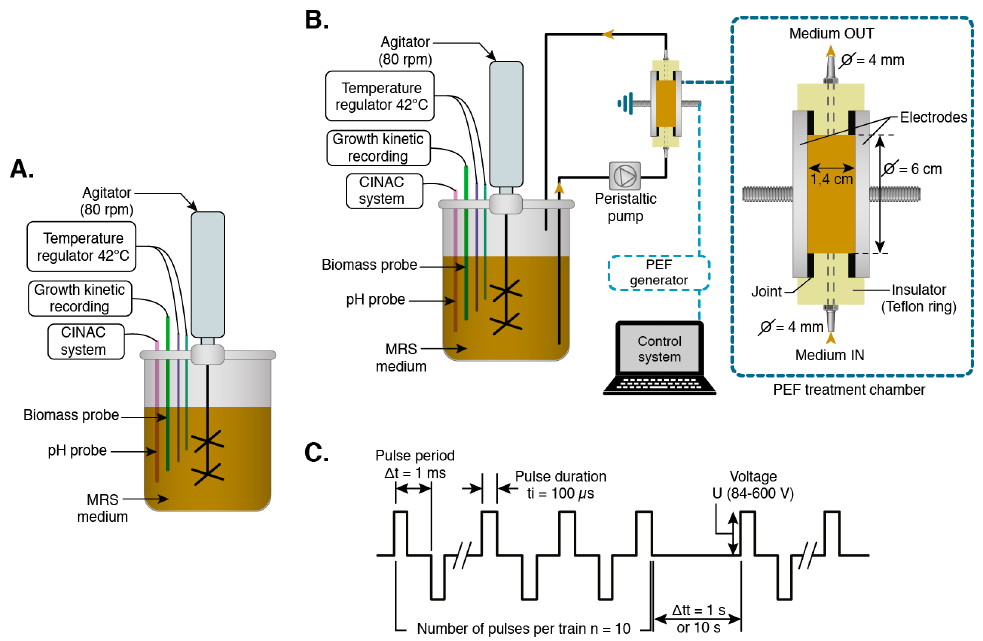
Figure 1. ( A ) Control fermentation. ( B ) pulsed electric fields (PEF)-assisted fermentation of L. delbrueckii subsp. bulgaricus CFL1. CINAC, acidification activity measurement. ( C ) PEF treatment parameters applied during the fermentation of L. delbrueckii subsp. bulgaricus CFL1.